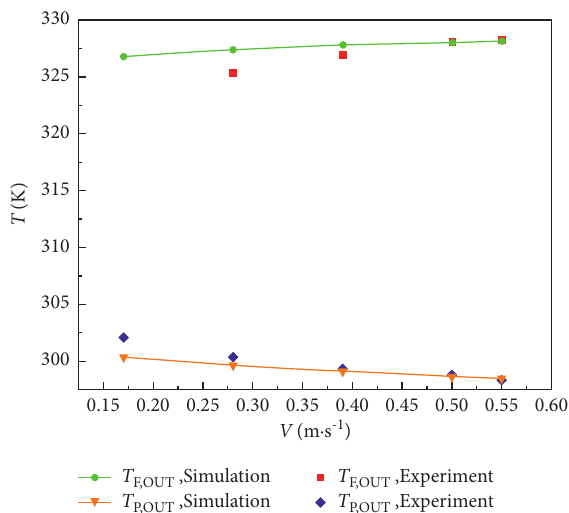
Figure 5: Comparison of outlet temperature between the simulating results and experimental data. V T P � 293K, W NaCl �